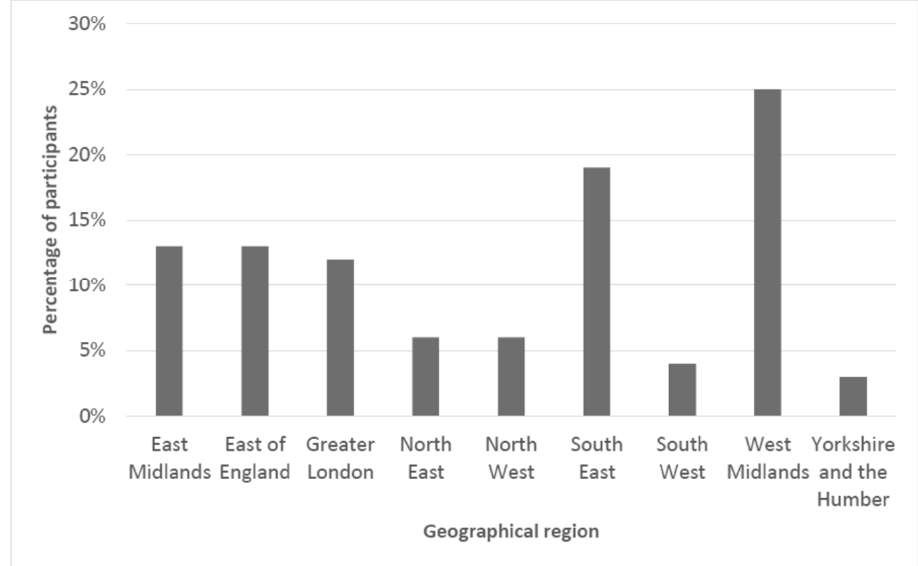
Buildings 2022 , 12 , x FOR PEER REVIEW Figure 2. The distribution of geographical regions worked in by respondents. Figure 2. The distribution of geographical regions worked in by respondents.